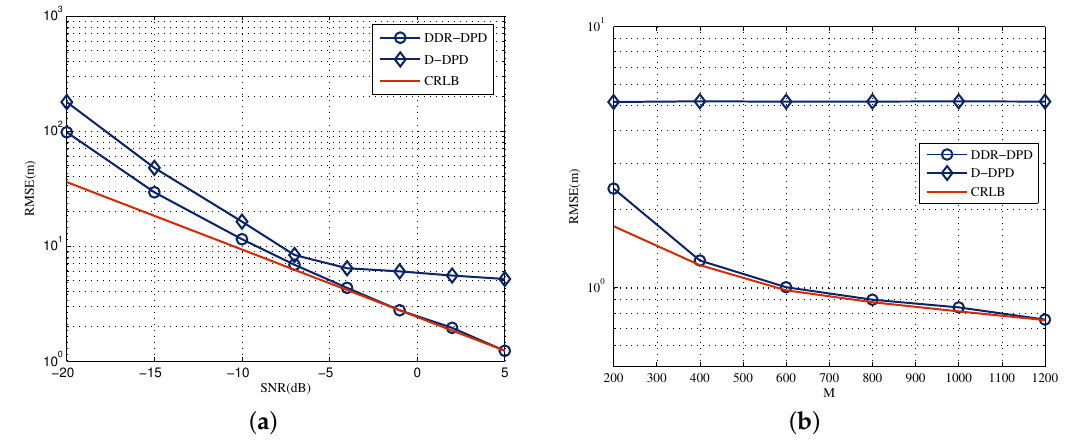
Figure 9. The performance of the proposed method with Set Id = 2. ( a ) the RMSE vs. SNR; ( b ) the RMSE vs.